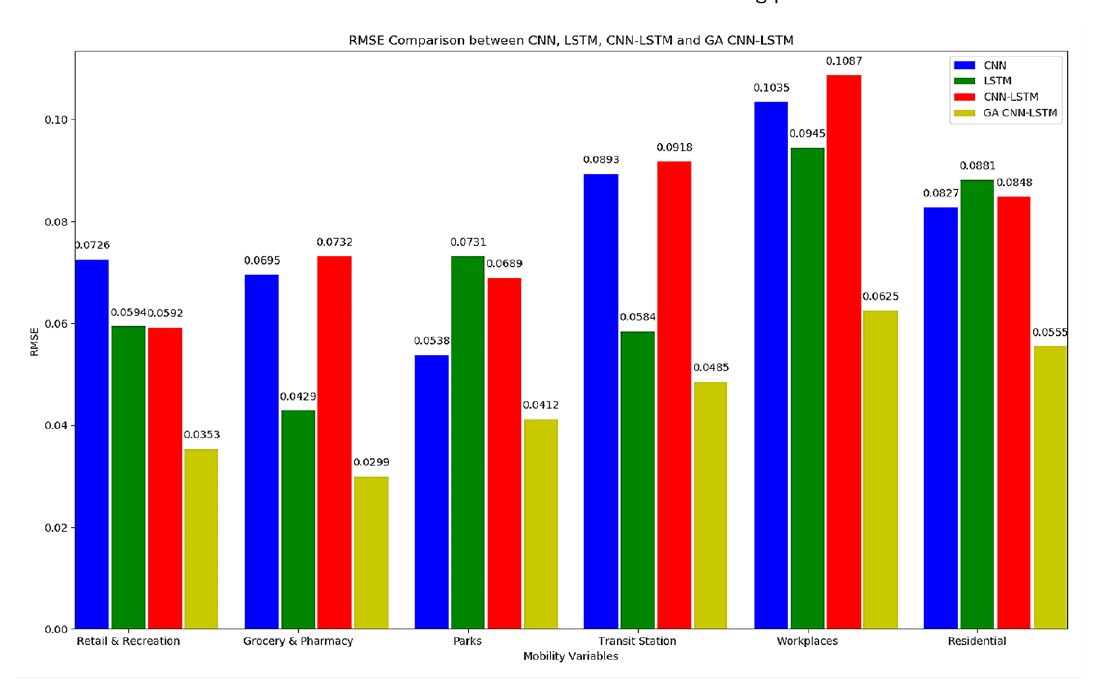
Figure 10. RMSE produced by each evaluated model for each mobility area.